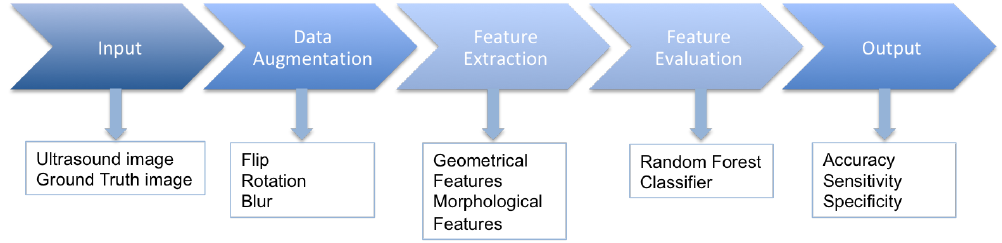
Figure 1. Workflow diagram.